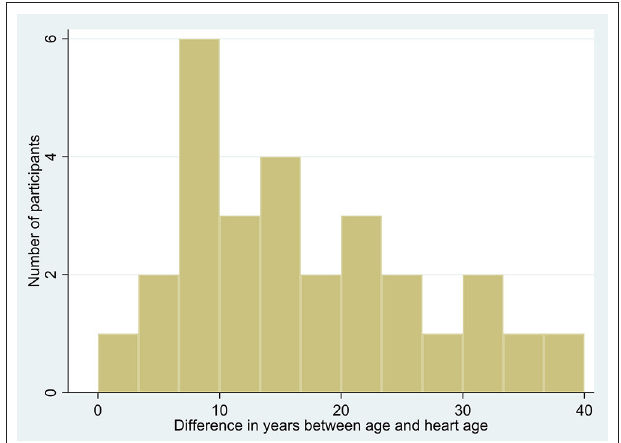
FIGURE 3 | Difference between age and heart